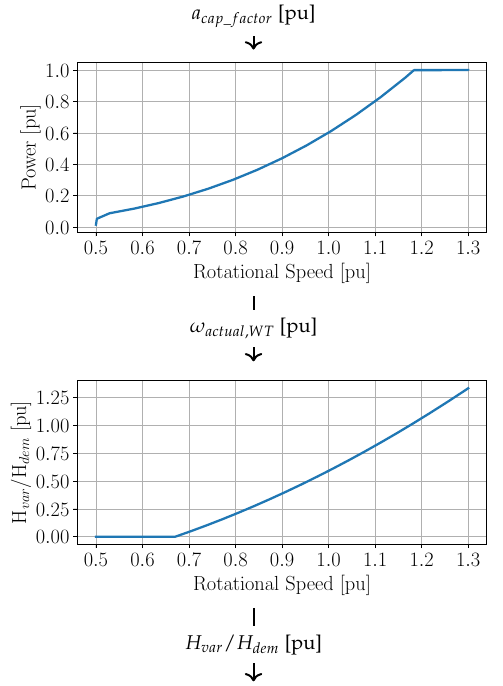
Figure 3. Visualised methodology to calculate H var / H dem . First, the NREL 5MW wind turbines’ nor- malised power vs. normalised rotational speed specifications are applied to calculate the normalised rotational speed [46]. Second, the normalised specifications of the variable H controller are applied to determine the variable inertia output [8]. Figure is based on data from